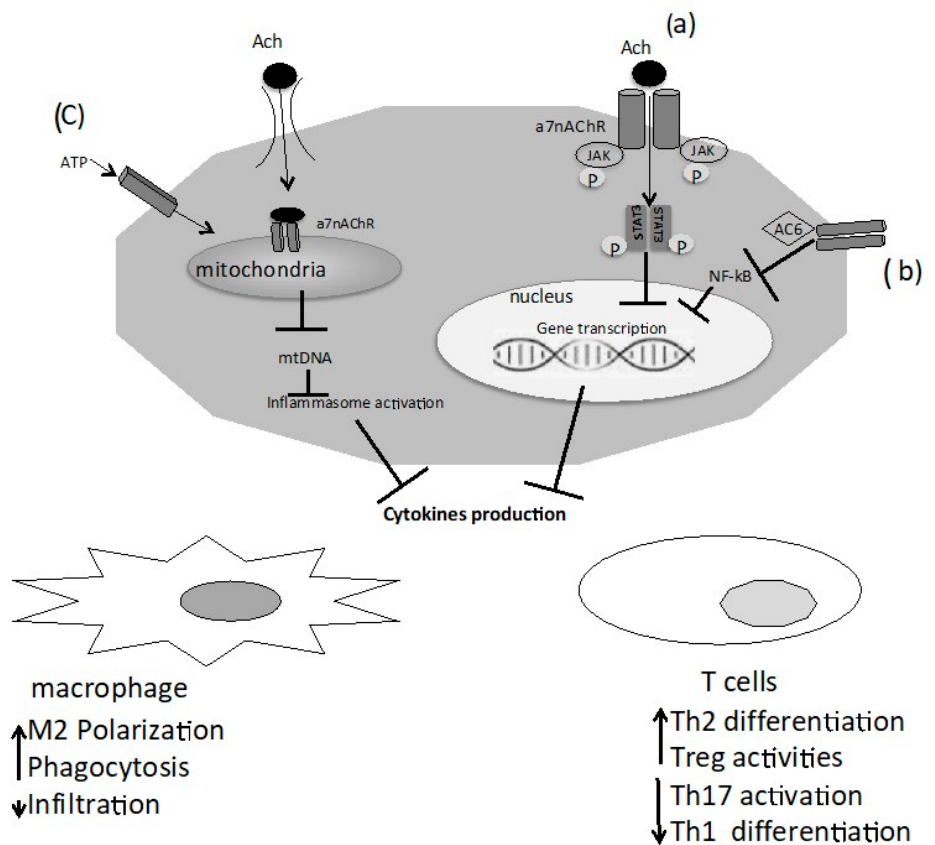
Figure 1. Macrophages and T cells expressed the α 7 nicotinic ACh receptor ( α 7 nAChR), and the binding of acetylcholine (ACh) to α 7 nAChR triggers intracellular signaling: ( a ) interaction between α 7 nAchR and JAK2 and consequently phosphorylation of STAT 3. Translocation of phosphorylated STAT3 dimers to the nucleus suppresses pro-inflammatory cytokines; ( b ) activation of adenylyl cyclase 6 (AC6) leads to the inhibition of NF-kB activity and suppression of pro-inflammatory cytokines; ( c ) an additional mechanism is the activation by extracellular ATP of immune cells, that run a rapid influx of ACh into the cytoplasm. In the cytoplasm, ACh interacts with mitochondrial α 7 nAChR and reduces mitochondrial DNA release, and inhibits inflammasome activation and cytokine release.